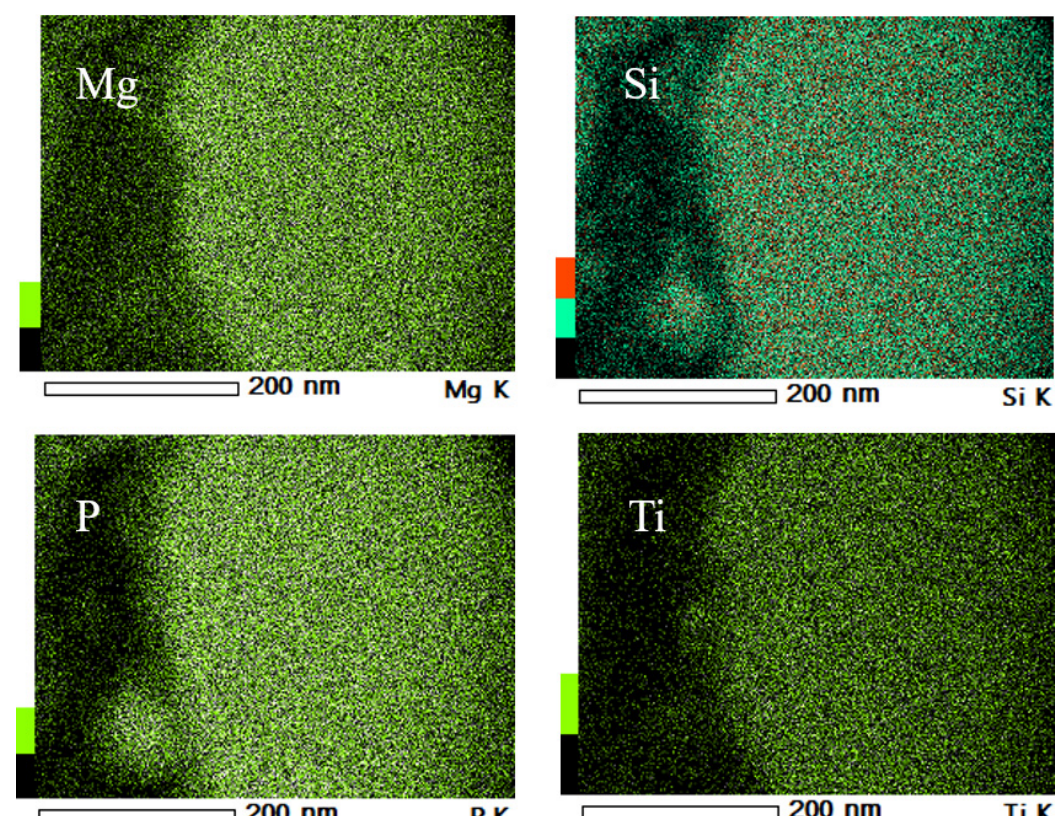
Figure 7. Distributions of Mg, Si, P, and Ti accompanying element map on Figure 6. Scale = 200 nm.